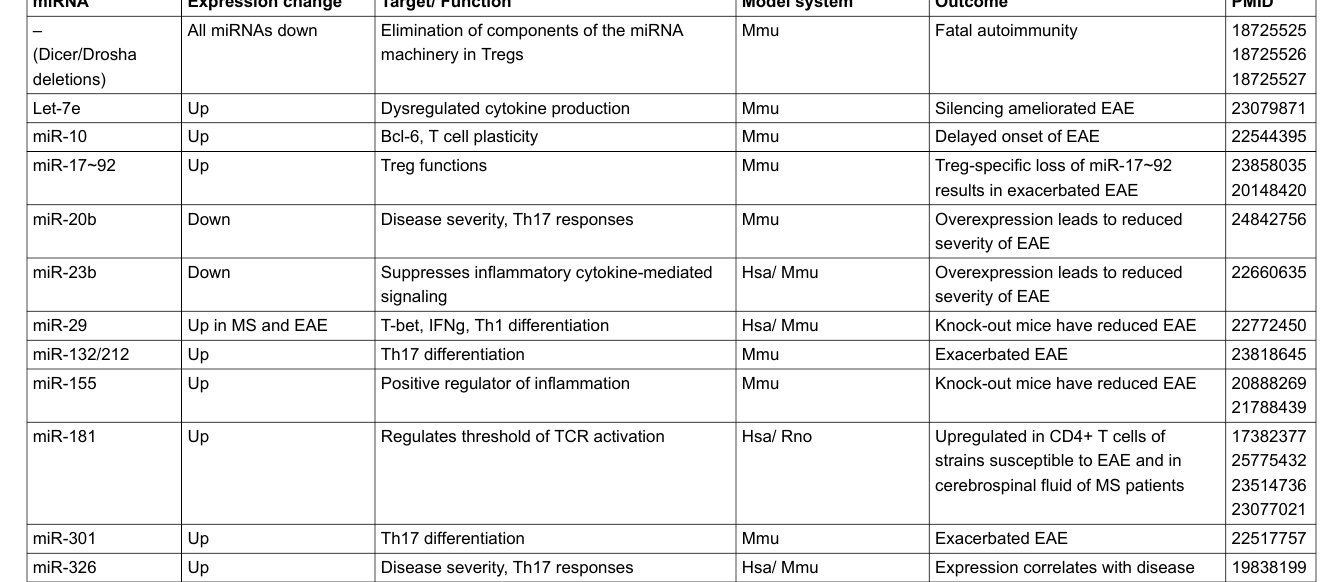
Table 1: Common miRNAs dysregulated in autoimmune diseases. Examples of some common miRNAs that have been reported to influence autoimmunity in general, MS or its experimental model (EAE) in humans (Hsa), mouse (Mmu) or rat (Rno). miRNA Expression change Target/ Function Model system Outcome